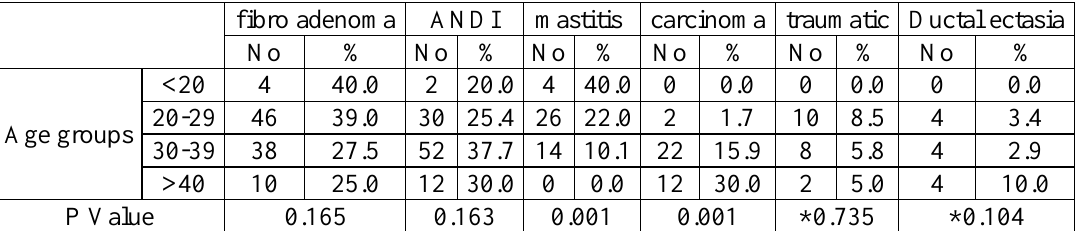
Table 3: Associations between the age groups and type of lesion fibro adenoma